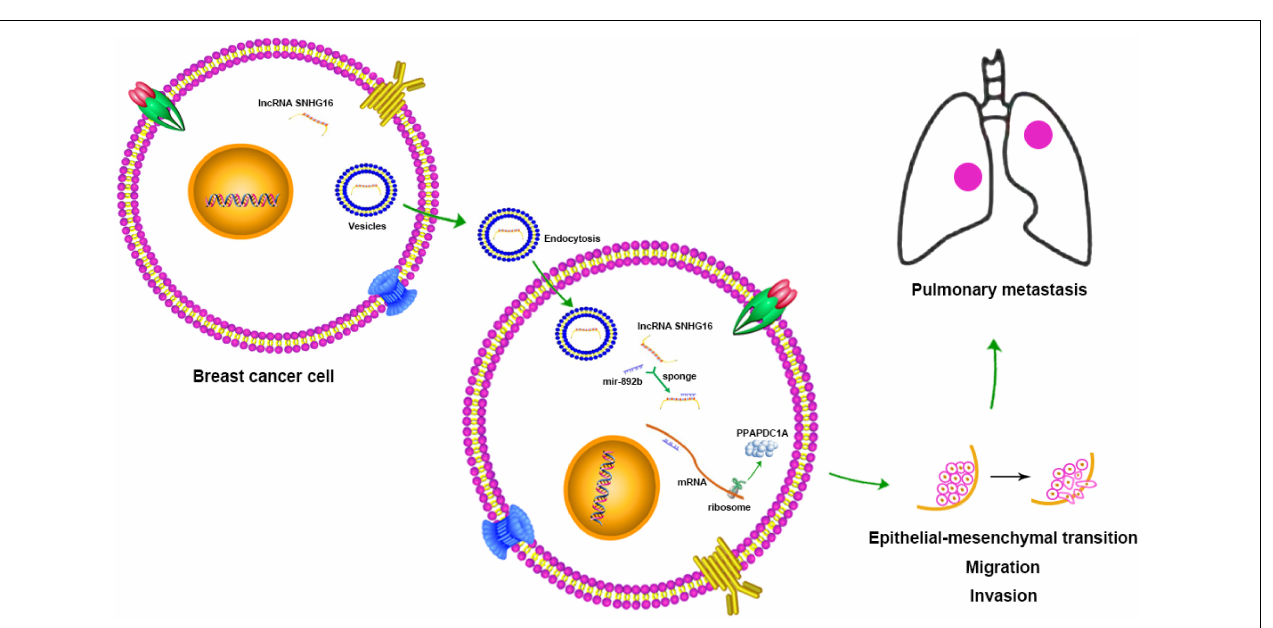
FIGURE 8 | Mechanism of lncRNA SNHG16 on the miR-892b/PPAPDC1A regulatory axis. The donor BC cell-secreted EVs carried lncRNA SNHG16 into the intercellular matrix, which was then encapsulated by the receptor cells and released SNHG16. The EVs carried SNHG16 competitively bound to miR-892b to